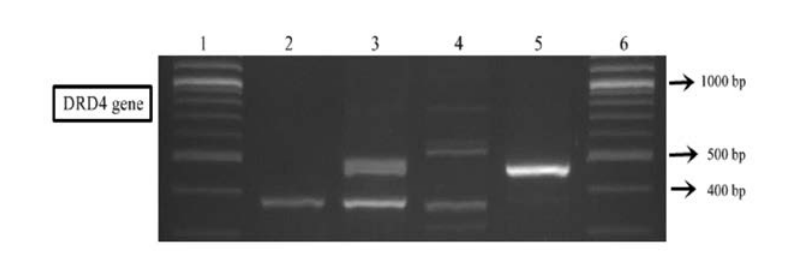
Figure 4. PCR Analysis of the DRD4 repeat polymorphism. PCR Analysis of the DRD4 repeat polymorphism. Lane 1: DNA Marker (100 bp). Lane 2: homozygote, 2- repeat. Lane 3: heterozygote, 2- and 4- repeat (REF 2/4). Lane 4: heterozygote, 2- and 5- repeat. Lane 5: homozygote, 4- repeat. Lane 6: DNA Marker. PCR products were run on a 3 % Agarose gel/1x TBE